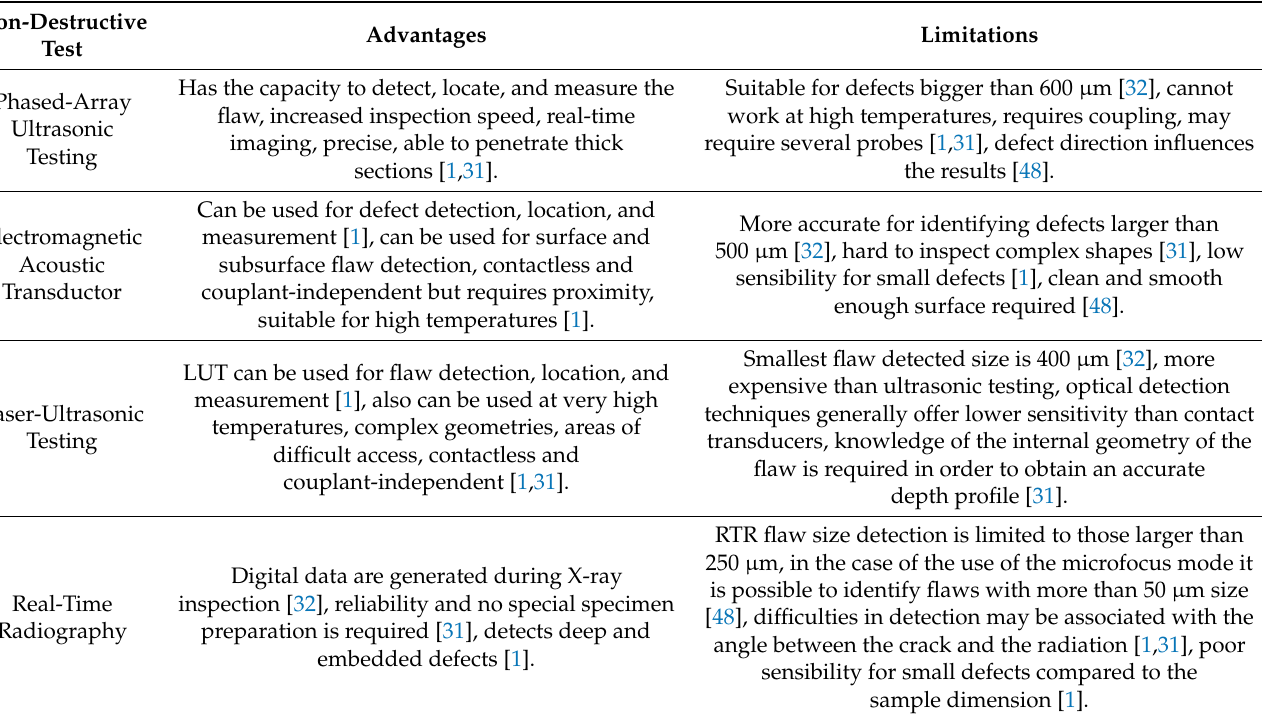
Table 2. Overview of in-line NDT in